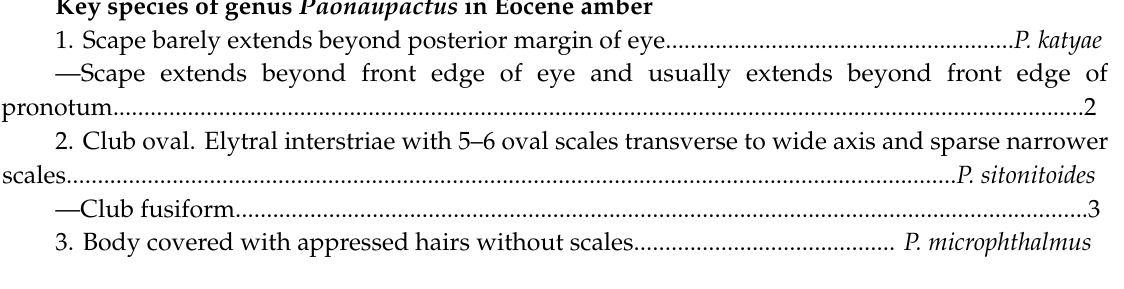
Figure 11. Habitus of Entiminae from Baltic and Rovno ambers. ( a ) Scuccinalophus attenboroughi , holotype, ISEA , no. BA2015 / 1, body, laterally. ( b ) Polydrosus scheelei , holotype, GPIH , no. 198, body, laterally. ( c ) Paonaupactus sitonitoides , holotype, GPIH , no. 197, body, ventrally. ( d ) Pyllobius cephalotes , holotype, ZMUC , no. 962, body, laterally. ( e ) Otiorhynchus pellucidipes , holotype, ZMUC , no. 961, body, laterally. ( f ) Paonaupactus sitonitoides , holotype, GPIH , no. 197, dorso-laterally; ( g ) P. viridis , holotype, EIW, no. 5637, body, laterally. ( h , j ) Arostropsis gusakovi sp. nov. , holotype, CVGM , no. 032C2014: body, laterally ( h ); body, latero-ventrally ( j ). ( i ) Paonaupactus katyae , holotype, MAIG , no. 5981, body, laterally. Scale bars: 1.0 mm. See Section 2 for names of collections.